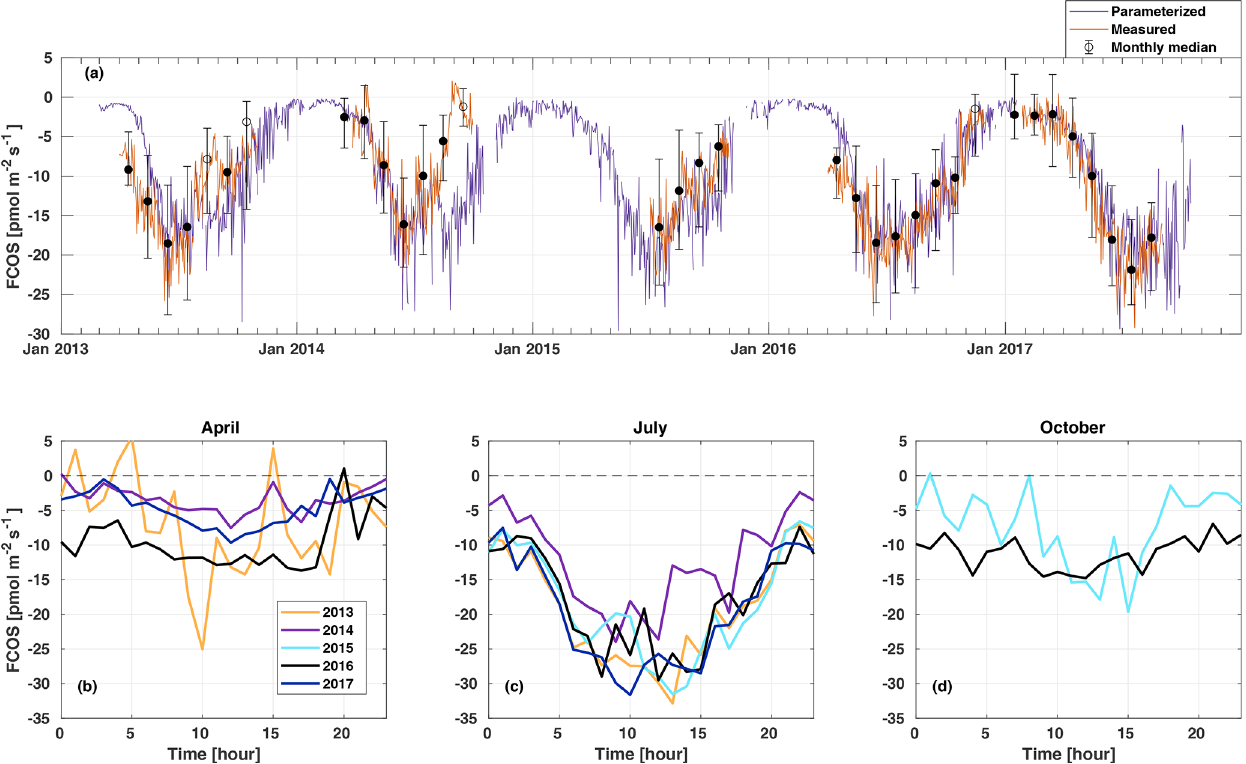
Figure 2. Daily average net carbonyl sulfide flux (FCOS) time series (a) and median diurnal variation in FCOS in April (b) , July (c) , and October (d) . A negative sign means COS uptake. Measured data (orange line in a ) show daily gap-filled averages (see Sect. 2.2), and black circles represent the monthly medians. Filled circles mean that more than 20% of data were measured, whereas empty circles indicate less than 20% of measured data for that month. Whiskers show the 25th and 75th percentiles. The purple line in panel (a) is the parameterized daily FCOS (see Eq. 1). Panels (b) – (d) represent measured (non-gap-filled) data only. No data are available for 2015 in April and for 2013, 2014, and 2017 in October. Parameterized values are shown for 5 full years. Times represent UTC + 2 (local winter